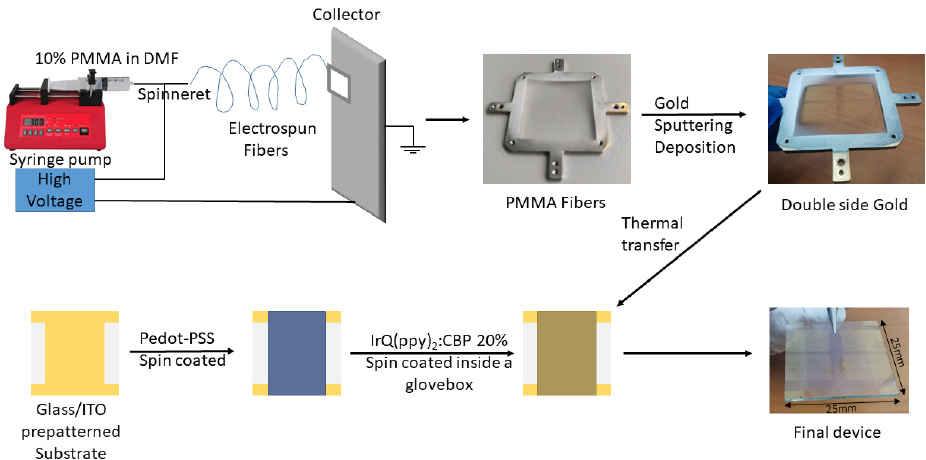
Figure 1. Fabrication procedure of the OLEDs with electrospun cathodes.